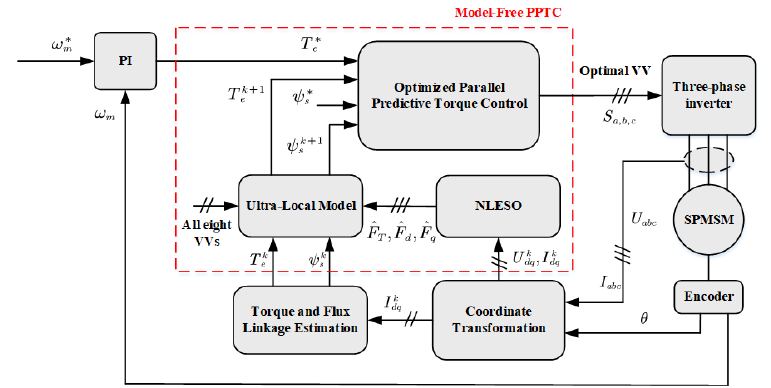
Figure 2. The control block diagram of the proposed